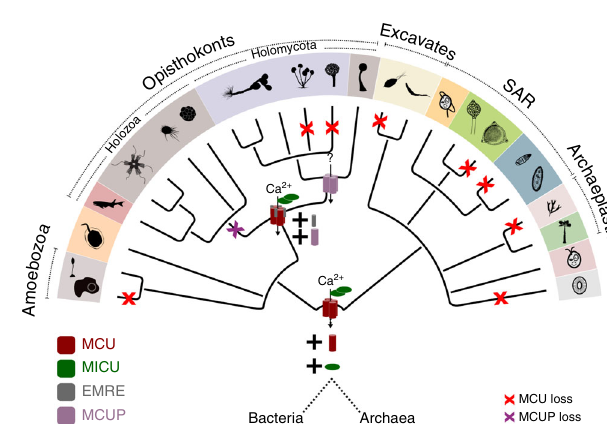
Fig. 5 Schematic representation of the evolution of the MCU complex in eukaryotes. Changes in the composition of the uniporter complex are shown in the respective taxonomic levels. The MCU – MICU complex emerges at the origin of eukaryotes, followed by the addition of EMRE in opisthokonts. MCUP is only found in Holomycota. Losses of MCU in the various eukaryotic lineages are indicated in red and the loss of MCUP in Holozoa in purple. The color code is the same as in Fig. 1, and the taxonomic tree structure and silhouette images of the different taxonomic groups are as in Fig. our work underscores that accurate phylogenomic analyses can resolve apparent evolutionary riddles while making explicit functional predictions that can drive future experiments.